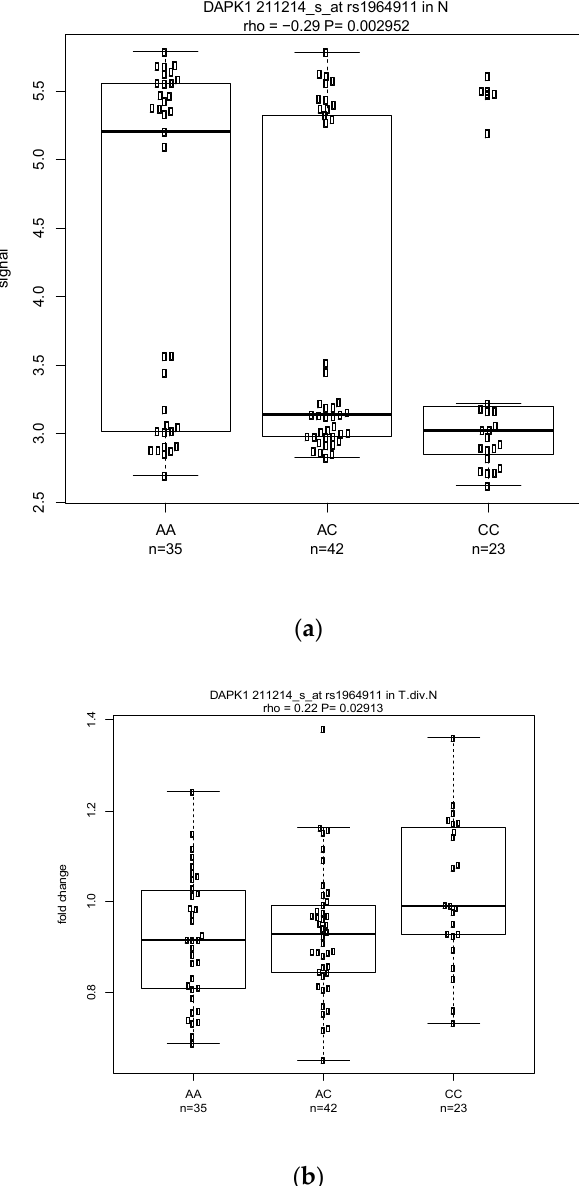
Figure 2. ( a ) Boxplot of the signal in normal and the Spearman correlation between signal and genotype with p = 0.003 and a negative rho = − 0.29 for the gene–SNP pair DAPK1 (211214_s_at) and rs1964911. ( b ) Distribution of the tumor vs. normal fold change and the correlation with p = 0.03 and a positive rho = 0.22 for the same gene–SNP